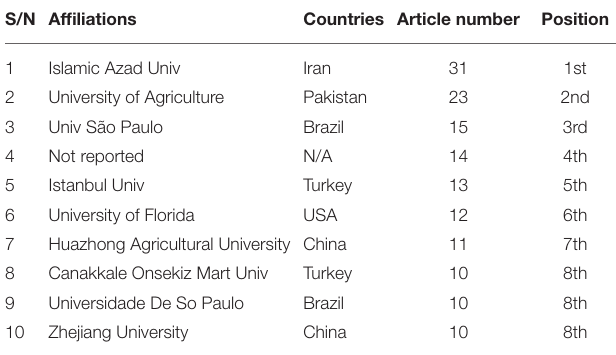
TABLE 8 | The top 10 most productive institutes on citrus waste and animal feed for livestock production with at 10 article publications. S/N